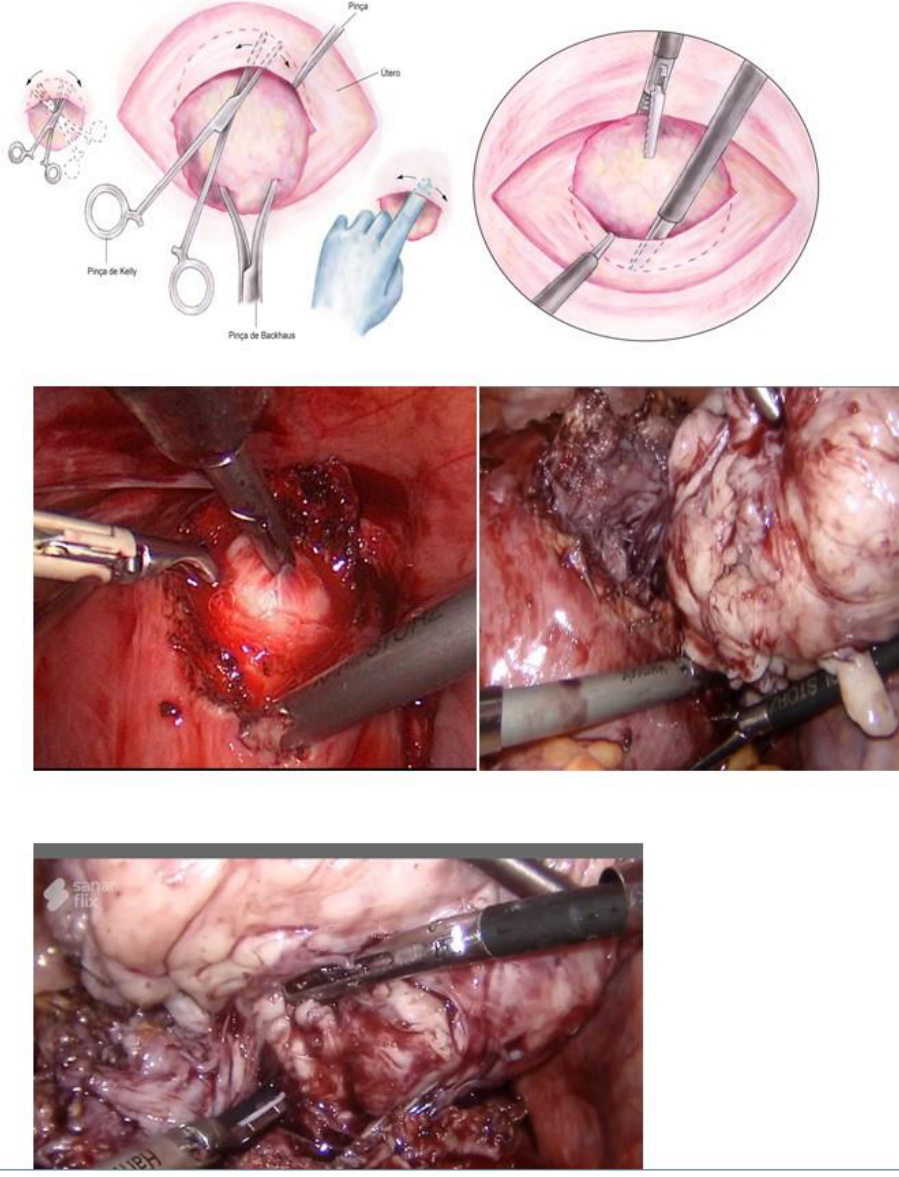
Figure 6. Laparotomic and laparoscopic myomectomy preserving pseudocapsule.